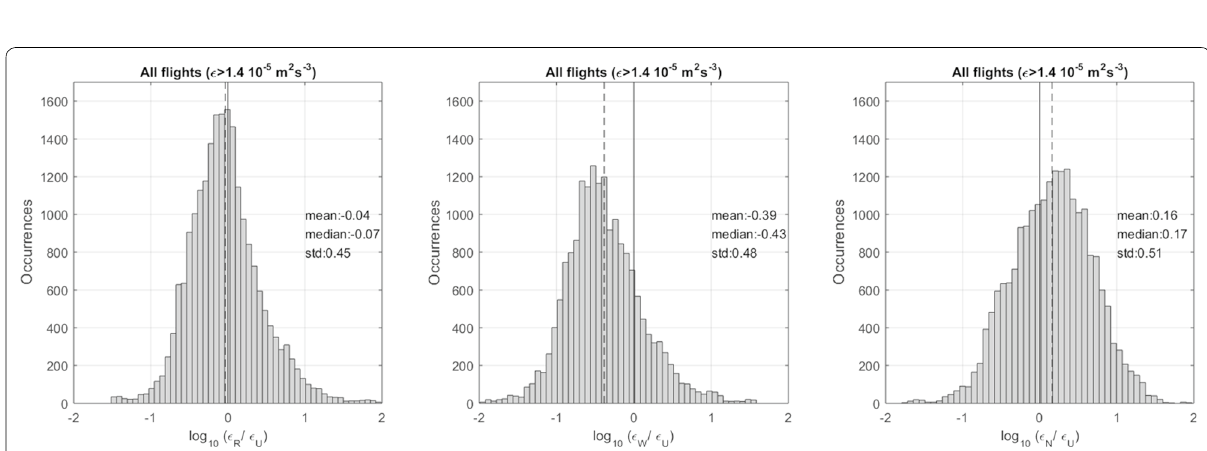
Fig. 14 Histograms of log 10 (ε R /ε U ) (left), log 10 (ε W /ε U ) (middle), and log 10 (ε N /ε UAV ) (right) corresponding to the values shown in Fig. 13 for all the ShUREX2016 and ShUREX2017